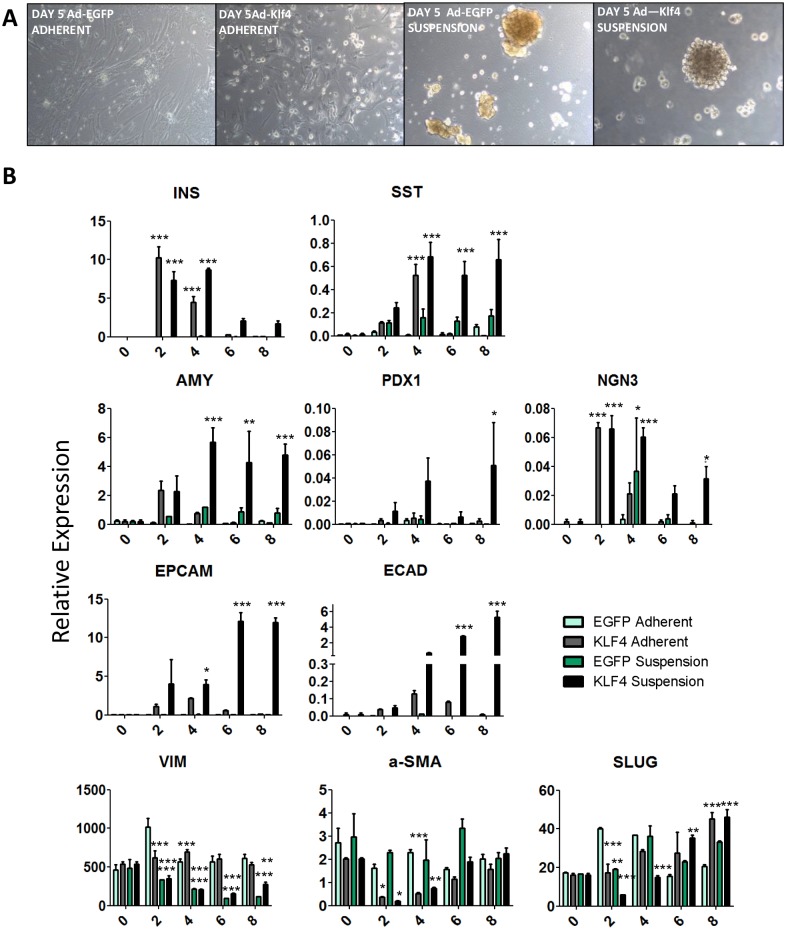
Suspension culture enhances the effects of Ad-Klf4.Islet-derived MSCs at passage 6 were transduced with Ad-Klf4 or Ad-EGFP and cultured overnight in adherent cell culture conditions. The cells were then either left in adherent conditions or transferred to suspension culture for a further 4 days. (A) Phase contrast comparison of cells in adherent or suspension culture at day 5. (B) Samples were harvested for QRT/PCR at several time points and analysed for expression of pancreatic, epithelial and mesenchymal markers. Data were expressed relative to glyceraldehyde-3-phosphate dehydrogenase and represent the mean ± SEM (n = 3). A one-way ANOVA was performed on all QRT/PCR analyses with Dunnett post hoc test comparing treatment groups with an Ad-EGFP control. Unpaired t-tests were performed where necessary. For all analyses, P *< 0.05 **P < 0.01 ***P < 0.001.